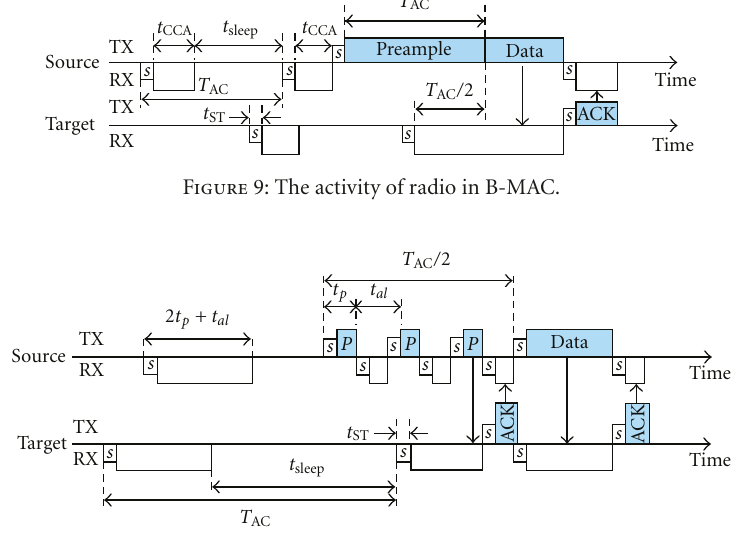
Figure 10: The activity of radio in